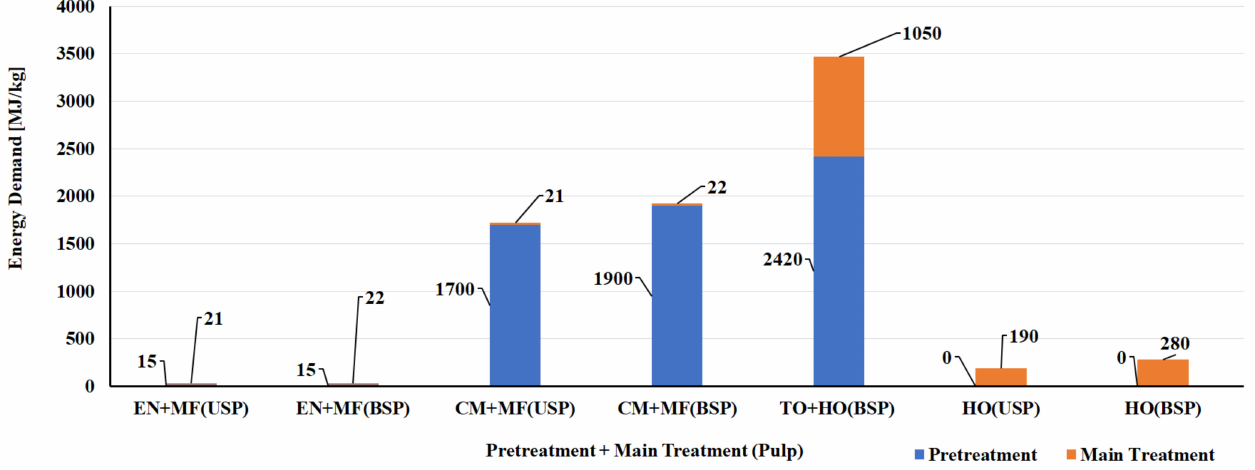
Figure 5. Energy demand for different pretreatment and main treatment processes of manufactur- ing CNF from bleached and unbleached sulfate pulp. Note: BSP—Bleached sulfate pulp, CM—